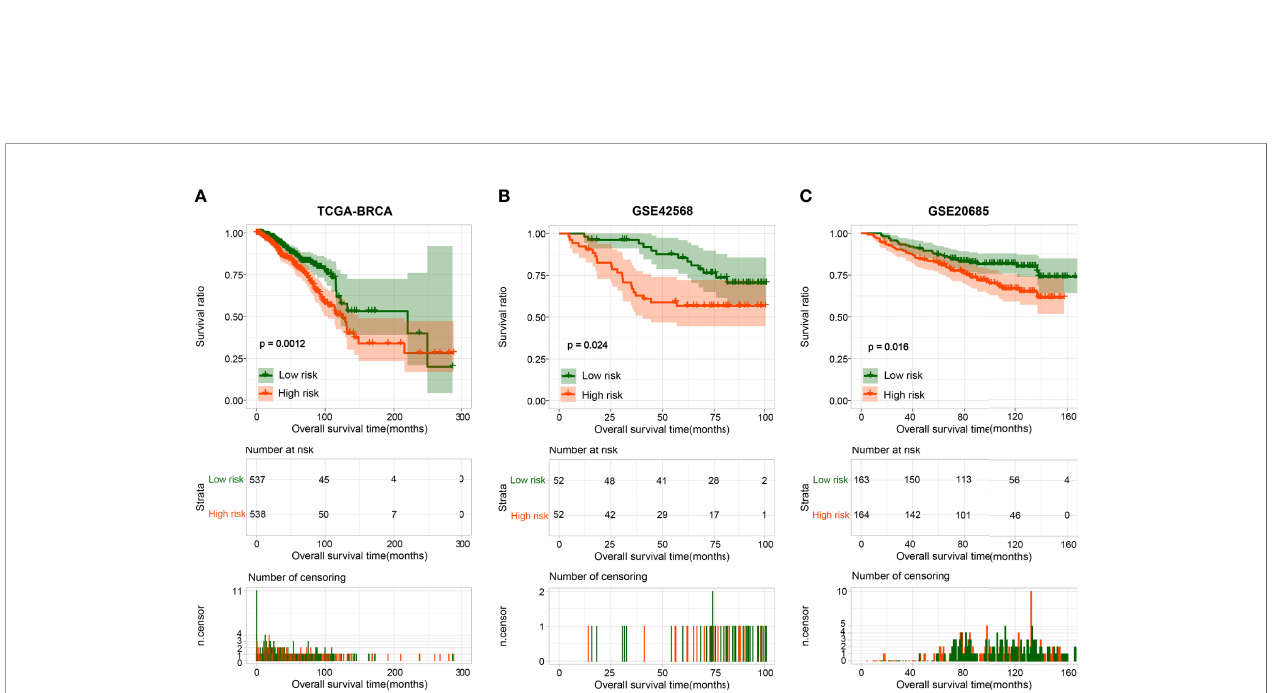
FIGURE 5 | The Kaplan-Meier analysis based on the prognostic signature. The Kaplan-Meier analysis for TCGA (A) , GSE42568 (B) , and GSE20685 (C) . The blue and red curves represent low- or high-risk samples,